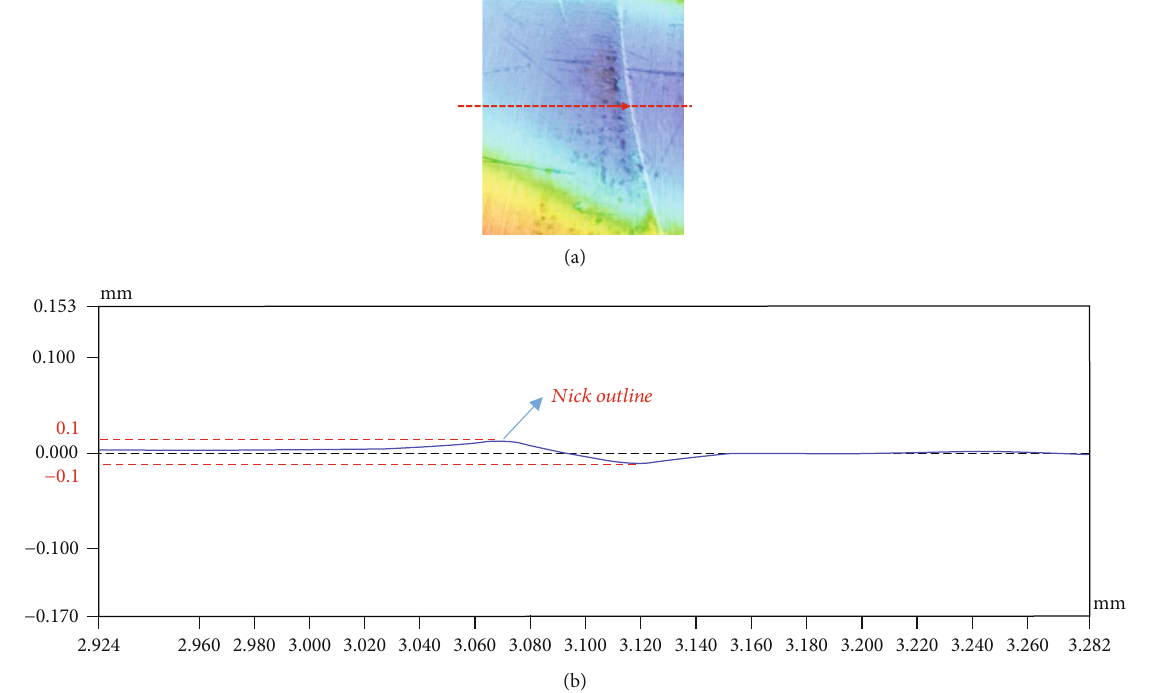
Figure 11: Three-dimensional scanning measurement of the chimeric curve. (a) Scanning nephogram. (b) Scratch depth and contour curve.